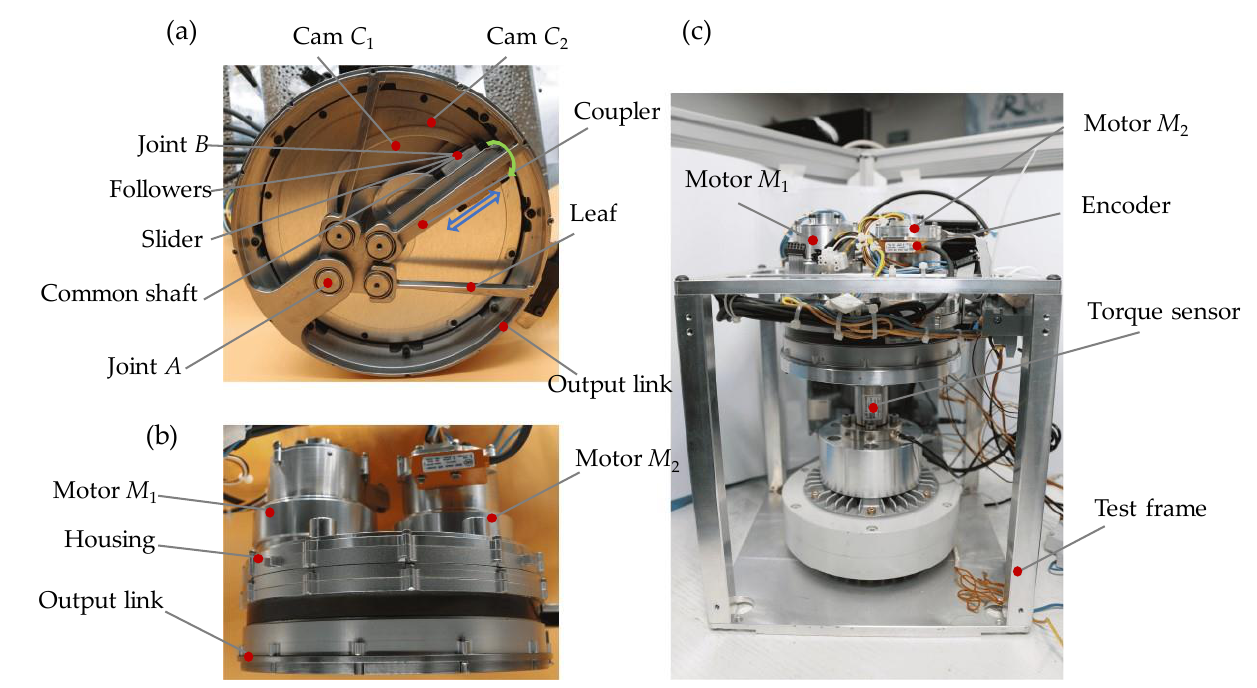
Figure 15. Physical prototype and experiment platform: ( a ) Bottom view of VSA; ( b ) Side view of VSA; ( c ) The test